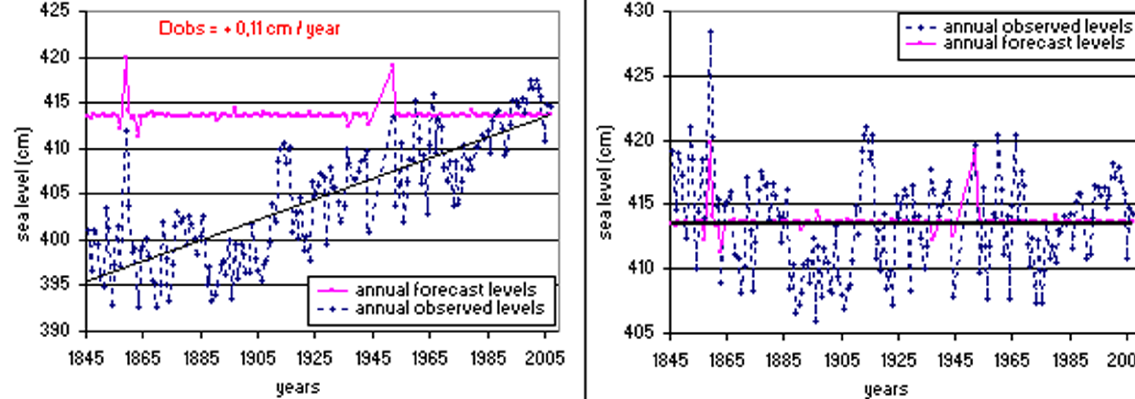
Fig. 4. Evolution of observed and predicted sea levels at Brest (1846–2009), before (left) and after (right) correction of the relative sea level rise by considering a linear trend for the observations. The “peaks” for annual predicted levels are explained by the limited amounts of data considered for the corresponding years (for instance, only 10% of the observed data are available for the year 1859. These 10% of data were measured during the month of December for which the tidal predictions were relatively important, which explains the suddenly high value of the annual predictions average for this year).